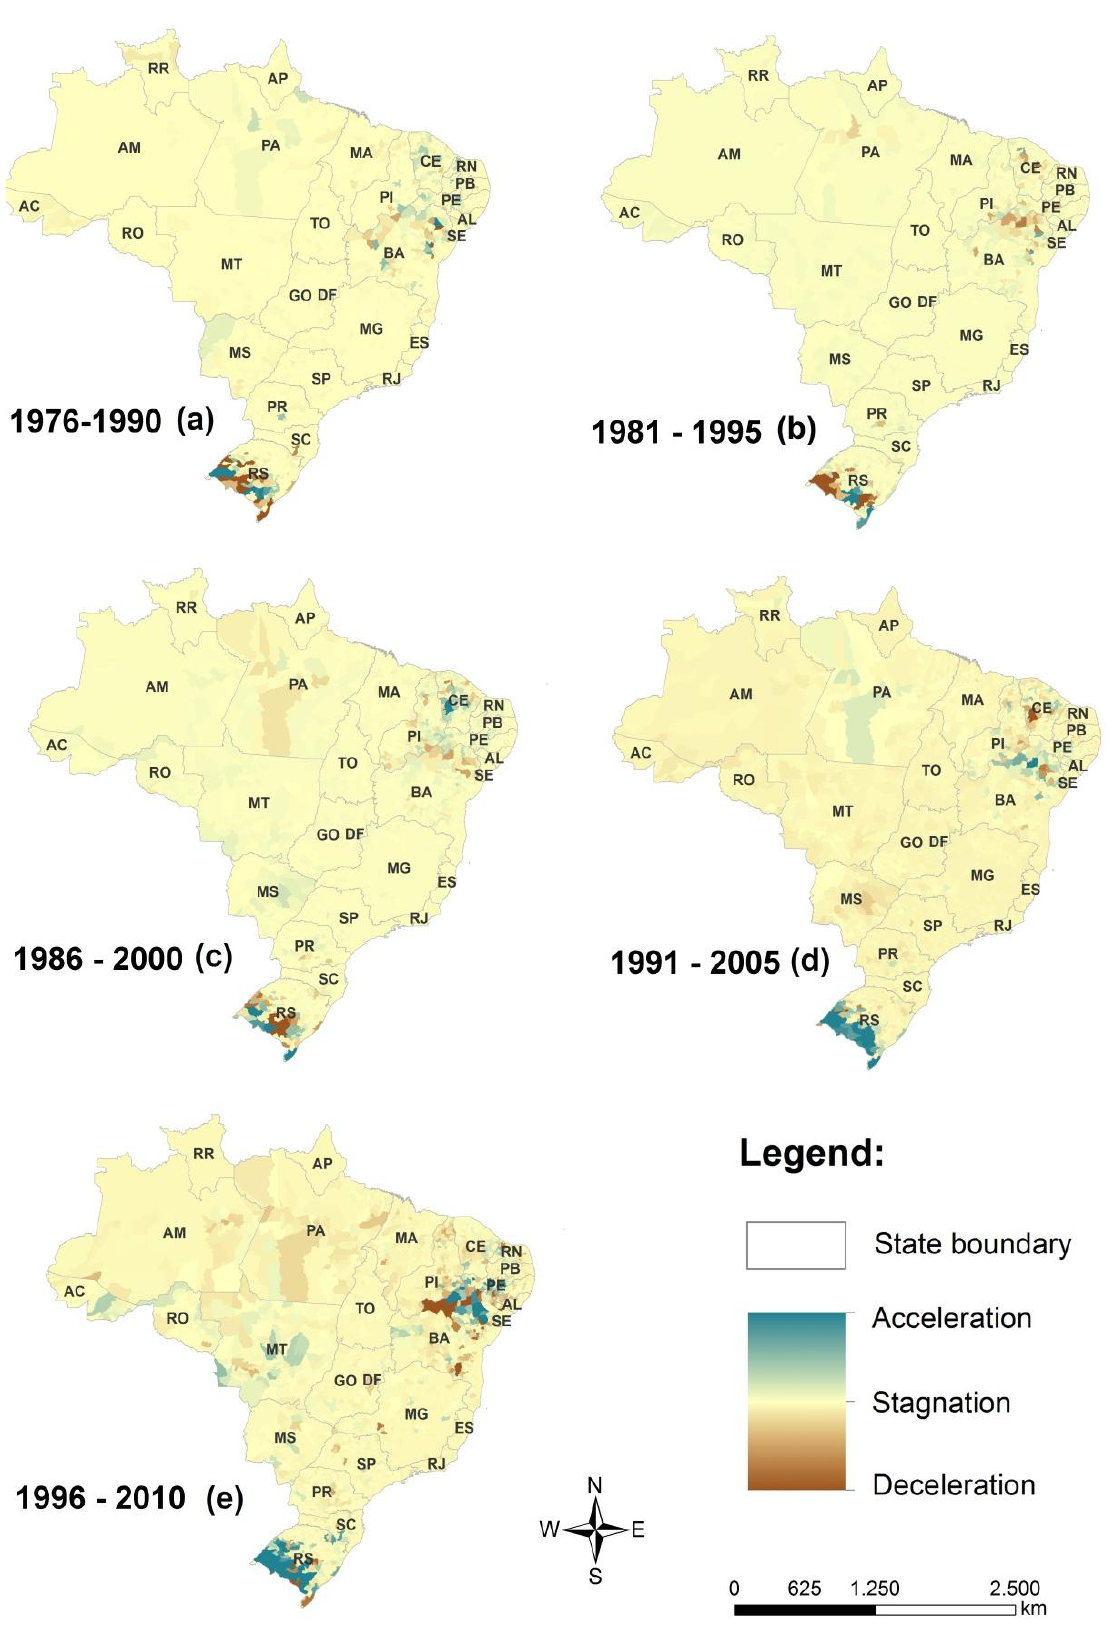
Figure 4. Acceleration of growth rates in sheep production in Brazil. ( a ) 1976 –